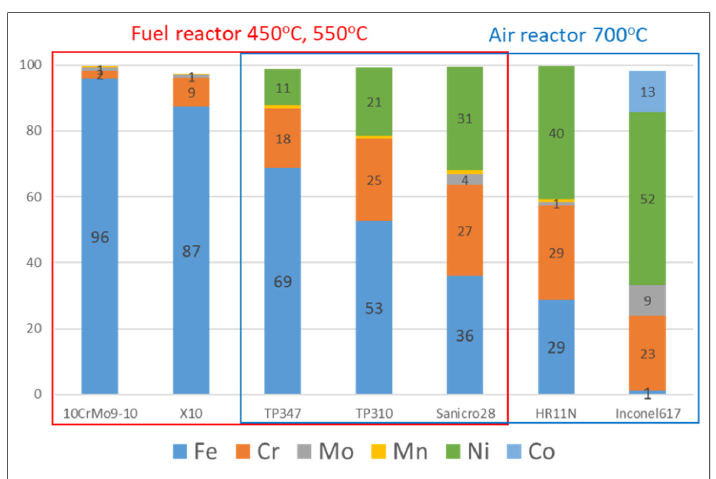
Figure 2. Nominal composition (wt%) of the tested boiler materials. Only the main components are indicated. The red and blue rectangular borders show the materials tested at 450 ◦ C or 550 ◦ C under fuel reactor conditions and 700 ◦ C under air reactor